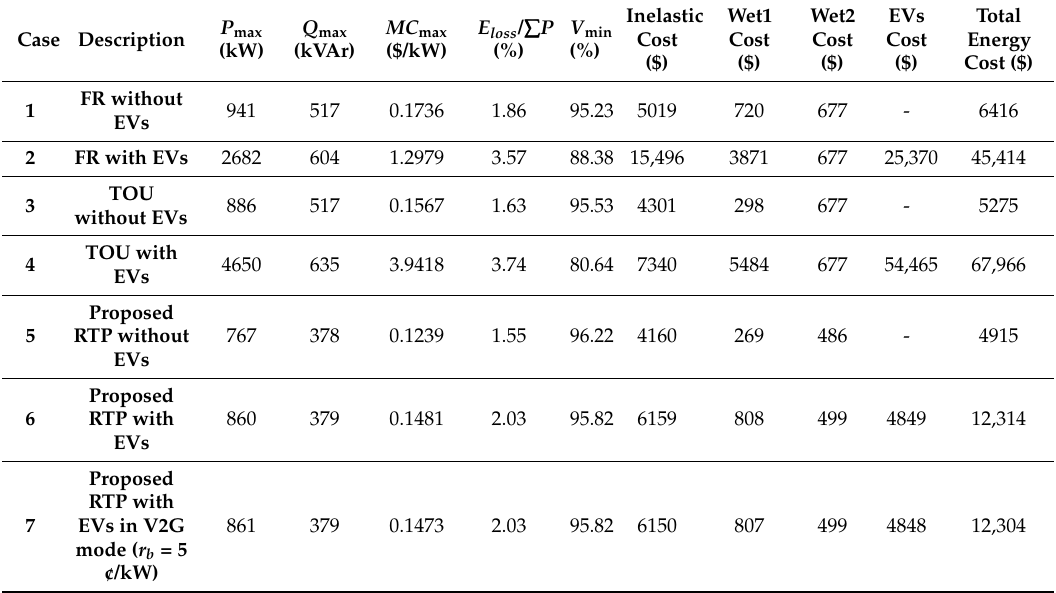
Figure 9. Total reactive power using FR, TOU and the proposed transactive method (RTP): ( a ) without EV; ( b ) With EVs. Table 1. Performance comparison of customer motivation methods under various EV settings.